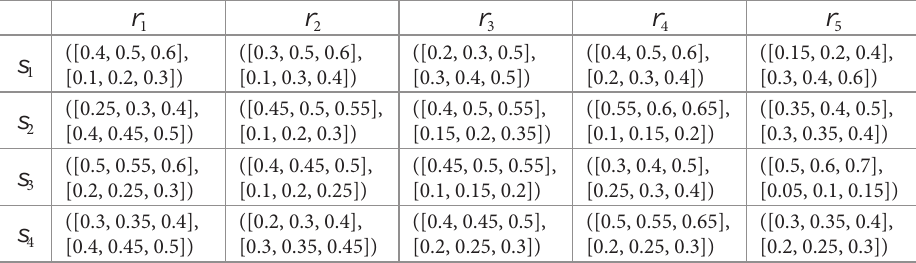
Table 1. The transformed evaluation information of the indicators of each candidate (the decision mak- ing matrix D